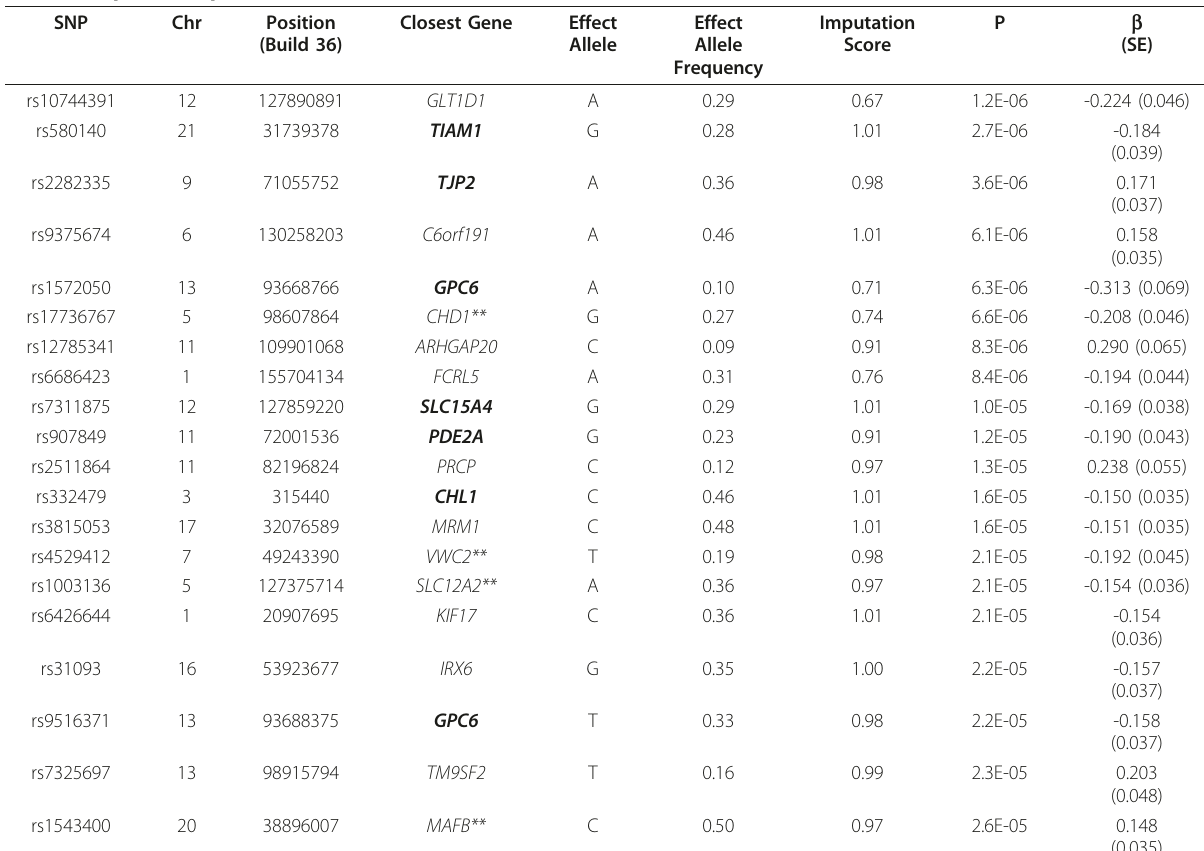
Table 3 Top 20 independent* SNPs associated with renal sinus fat SNP